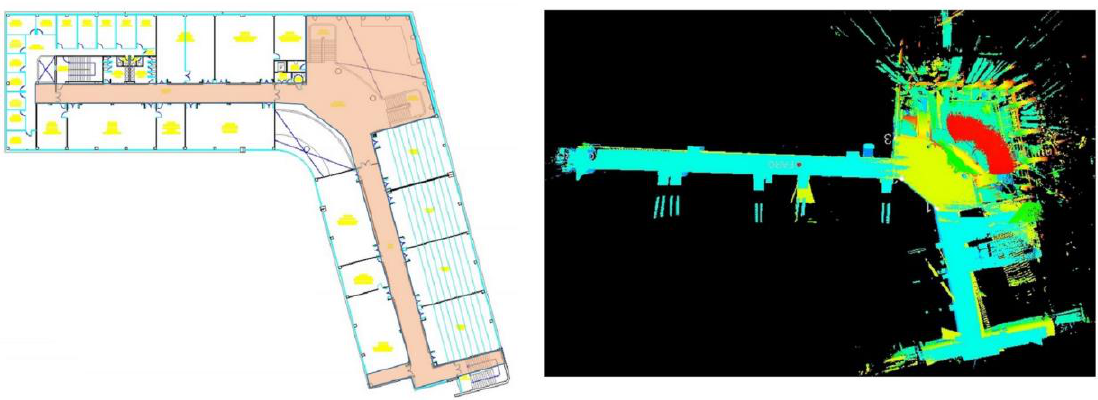
Table 4. Drift evaluation of IMAS; inspection path: 31 m.